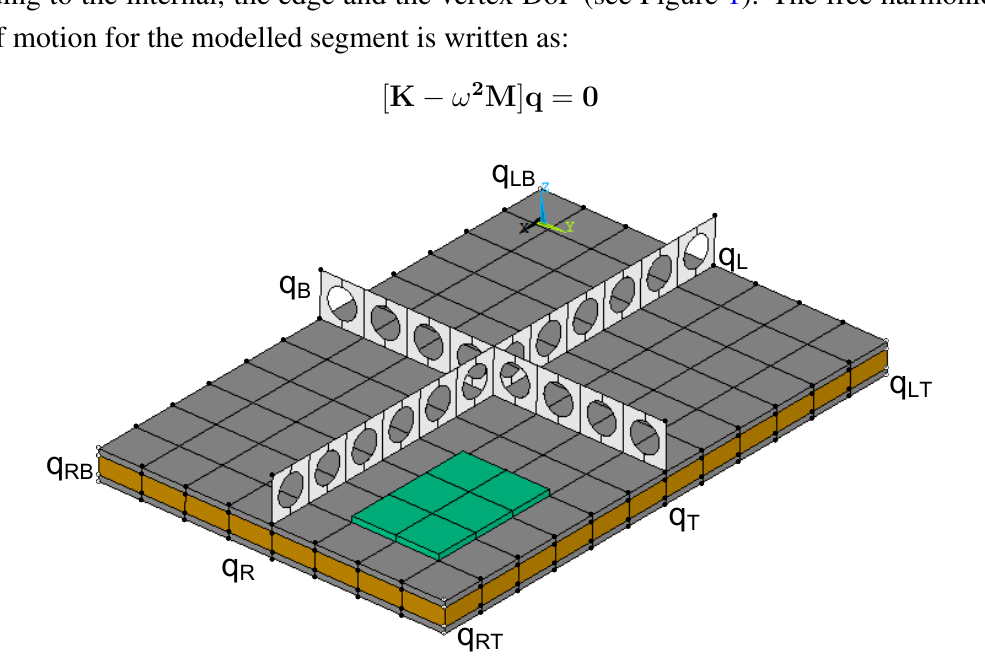
Figure 1. A finite element modelled periodic segment of a generic smart layered stiffened